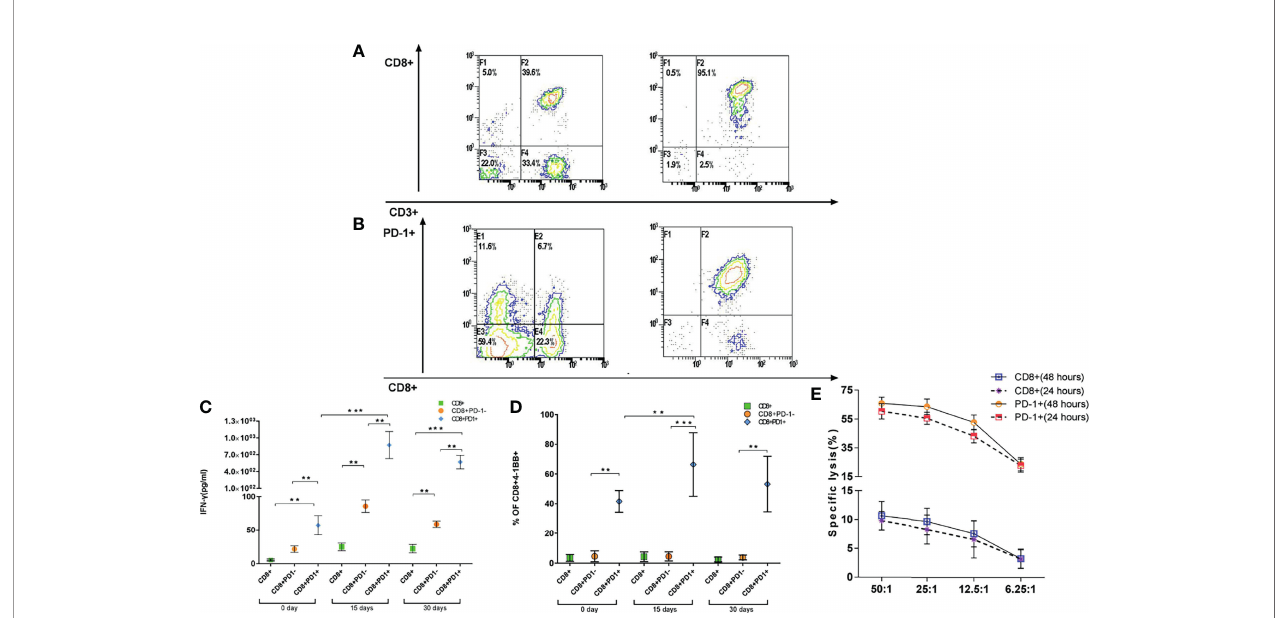
FIGURE 4 | CD8 + PD-1 + T cells could be identi fi ed as tumor-reactive CD8 T cells. (A, B) CD8 + and CD8 + PD-1 + T cells were sorted to identify the tumor-reactive T cells by ELISPOT and CCK-8. (C, D) Reactivity of PD-1 + and PD-1 − CD8 + T cells derived from patients against autologous tumor cell lines. IFN- g release and upregulation of 4-1BB (mean ± SD) are shown. (E) Lysis of HLA-A2+ matched tumor cells by patient-derived CD8 + T cell. *p < 0.05, **p < 0.01, ***p < 0.001, Mann – Whitney test. ELISPOT, enzyme-linked immunospot; CCK-8, Cell Counting Kit-8.